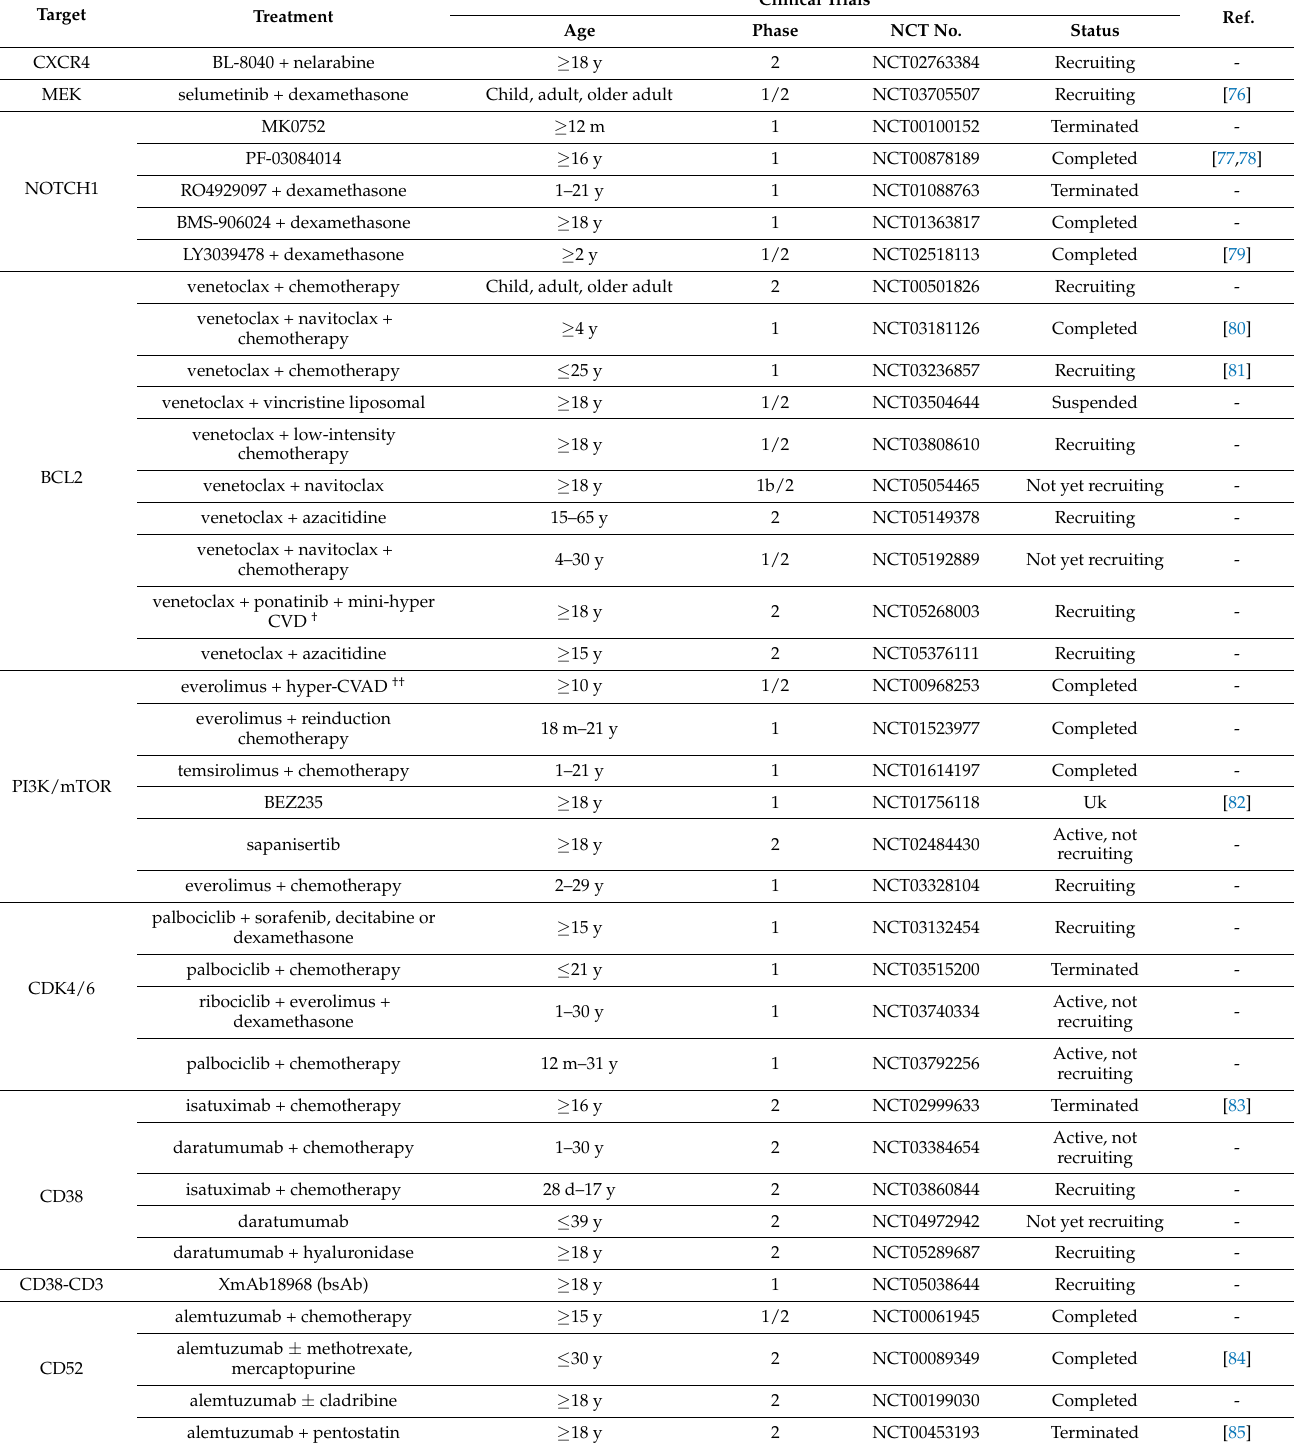
Table 1. Overview of agents evaluated in clinical trials including